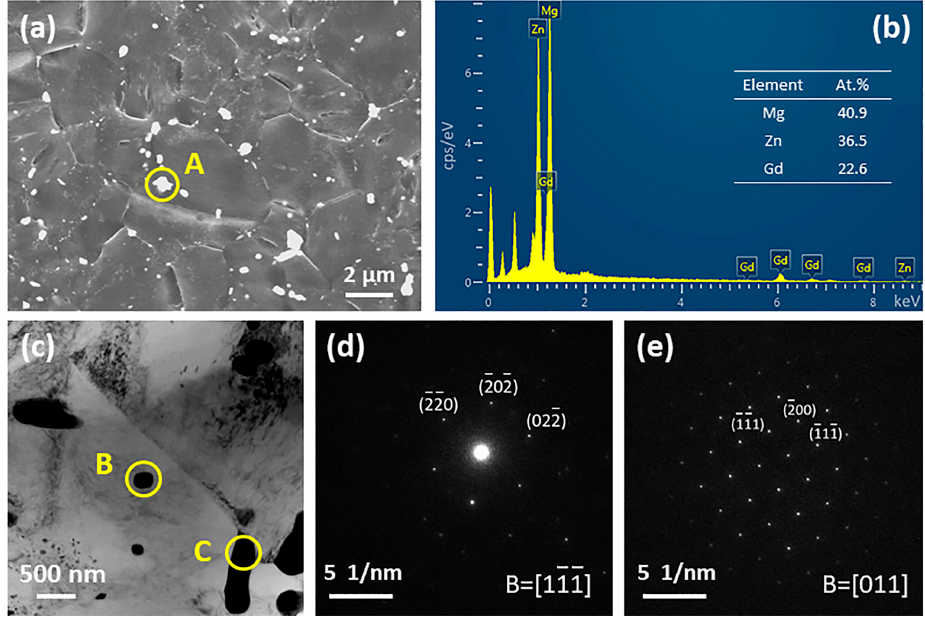
Figure 6. SEM and TEM analysis of as-extruded Alloy4: ( a , c ) Micrographs of broken particles, ( b ) energy dispersive X-ray spectrometer (EDS) result of particle A, ( d , e ) corresponding SAED patterns of particle B and C, respectively. Table 2. Average grain size of the investigated as-cast and as-extruded alloys. Condition